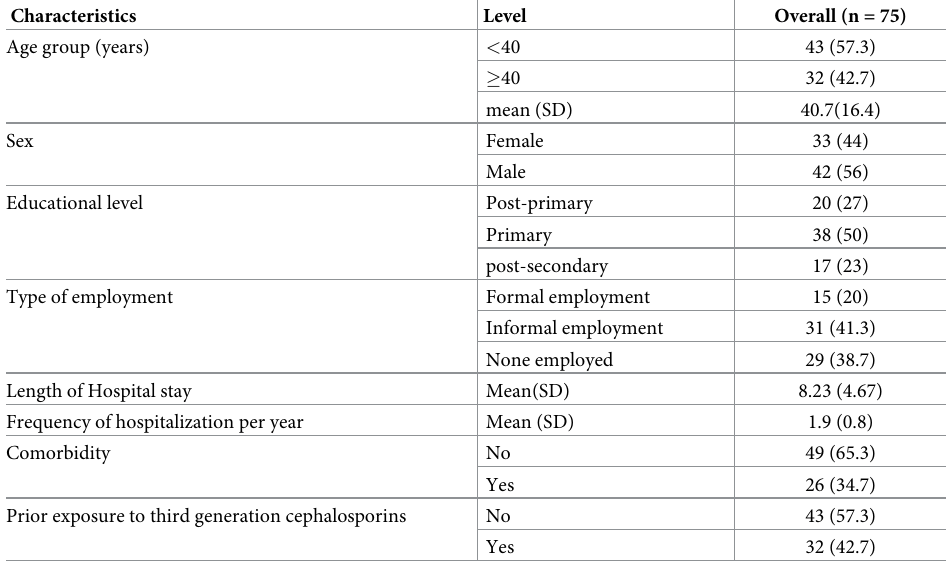
Table 3. Demographic and clinical characteristics of respondents.